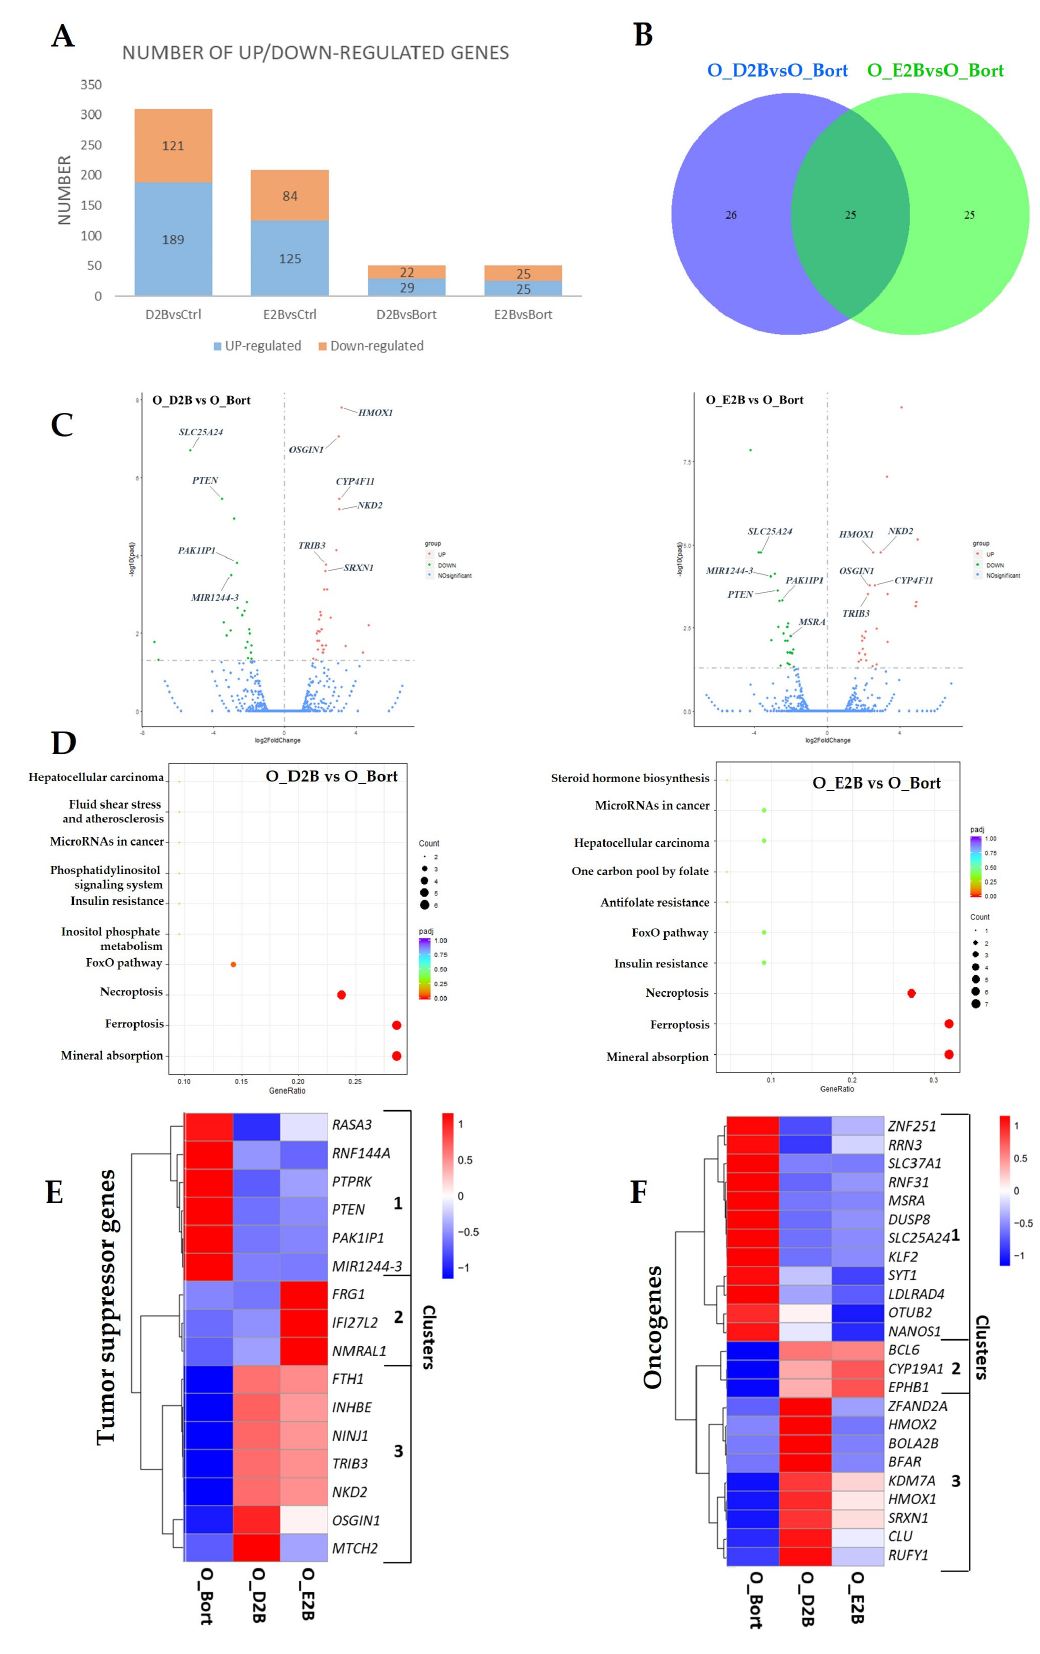
Figure 3. Pretreatment with DHA or EPA before bortezomib differentially regulated tumor-associated gene expression in the OPM2 cell line. Cells were pretreated with 50 µ M of DHA or EPA for 0 and 2 h and treated with bortezomib (10 nM)